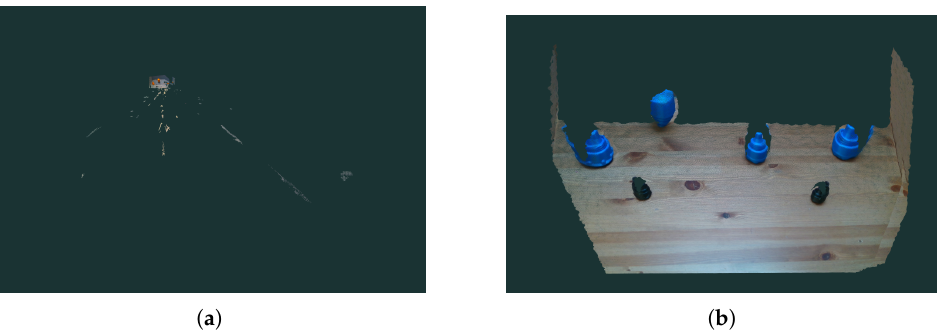
Figure 5. ( a ) Original point cloud captured by a RGB-D sensor, ( b ) the same point cloud after removing the unwanted